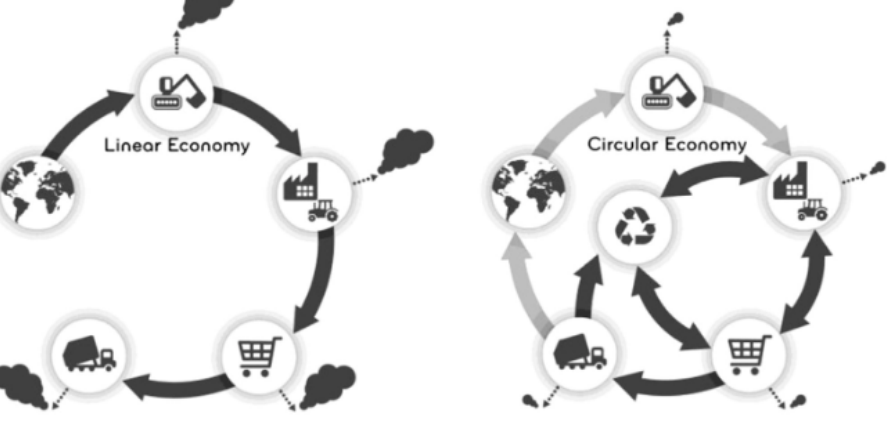
Figure 1. Circular economy vs. linear economy [20,25].